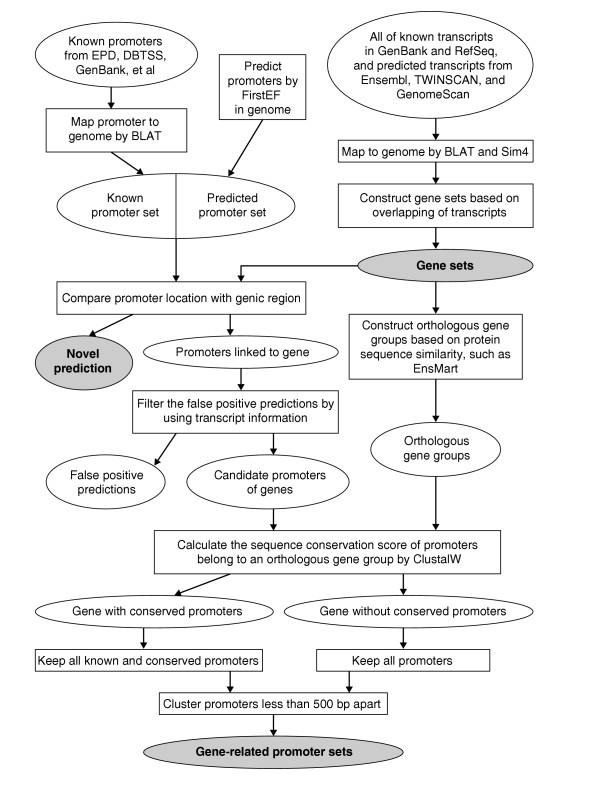
Flowchart of the pipeline to construct the promoter database. Ovals indicate data and rectangles the method. The ovals shaded gray represent the data stored in CSHLmpd.